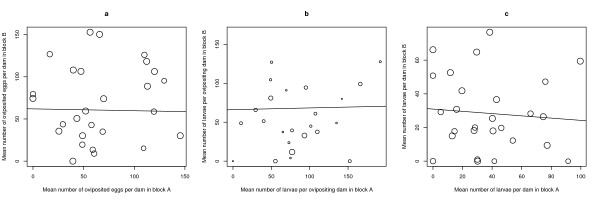
Scatter plots of male fitness traits 4, 5 and 6. Scatter plots of 27 sire families in blocks A and B for (a) mean number of oviposited eggs per dam (r = 0.09, df = 25, p = 0.67), (b) mean number of larvae per ovipositing dam (r = 0.25, df = 22, p = 0.241) and (c) the mean number of larvae per dam (r = -0.084, df = 25, p = 0.676). The sizes of the data points are proportional to the geometric mean of the number of dams in the denominator of the trait of interest in blocks A and B. Shown are the lines of best fit.